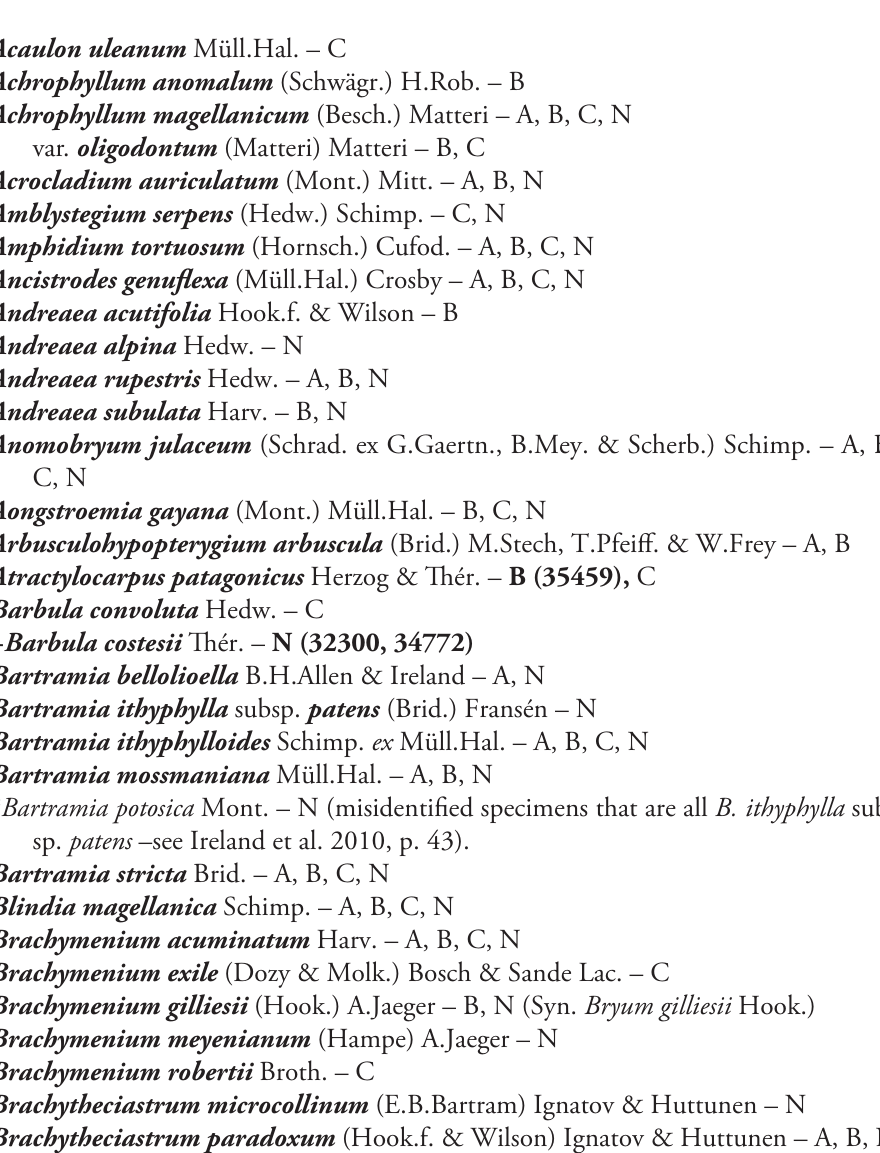
Checklist of the mosses of the Bío-Bío Region of Chile +++ New to South America; ++ New to Chile; + New to Bío-Bío Region (Región VIII); * Excluded from Chile; ** Excluded from Bío-Bío Region. (Provinces of the Bío-Bío Region represented by the following letters: A=Arauco; B=Bío-Bío; C=Concepción; N=Ñuble). All new provincial records since Ireland et al. (2010) paper, list the province in bold print indicating the corresponding voucher(s) in